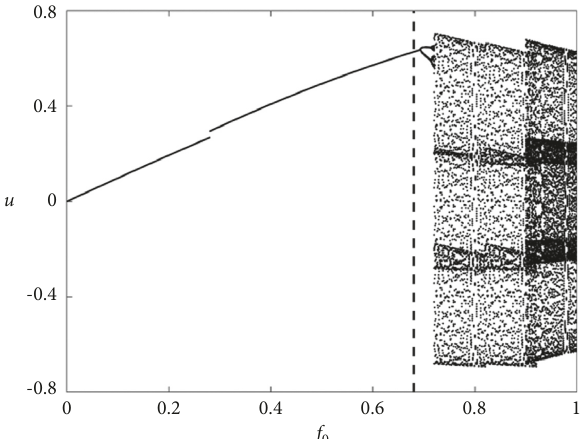
Figure 13: Bifurcation diagram of system (2) with the increase of f when α � 0 . 1 and ω � 1 . 0